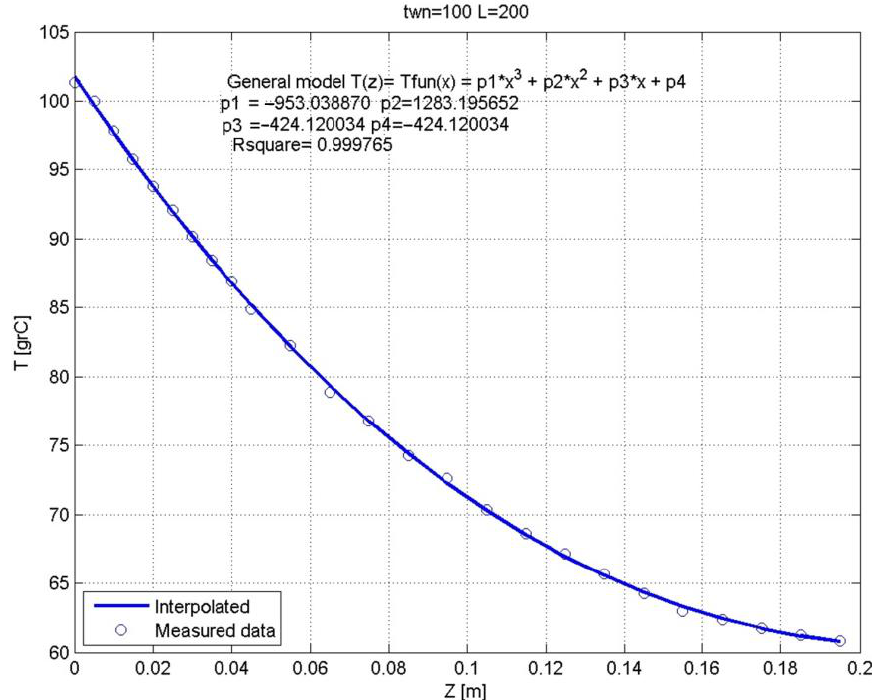
Figure 7. The third-degree polynomial approach of the experimentally measured data for t O , n = 100 ◦ C ; α g = 90 ◦